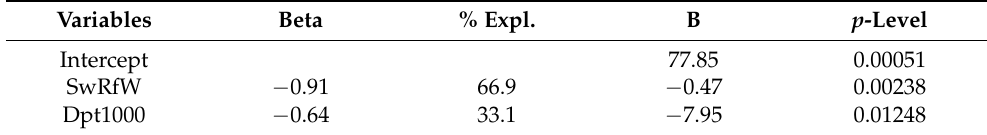
Table 3. Results from statistical regression, cases behind coral protection, with SwRfW as the width of shallow coral reef in meter, and Dpt1000 as the water depth (in meter) at 1000 m from the shoreline. % Expl.